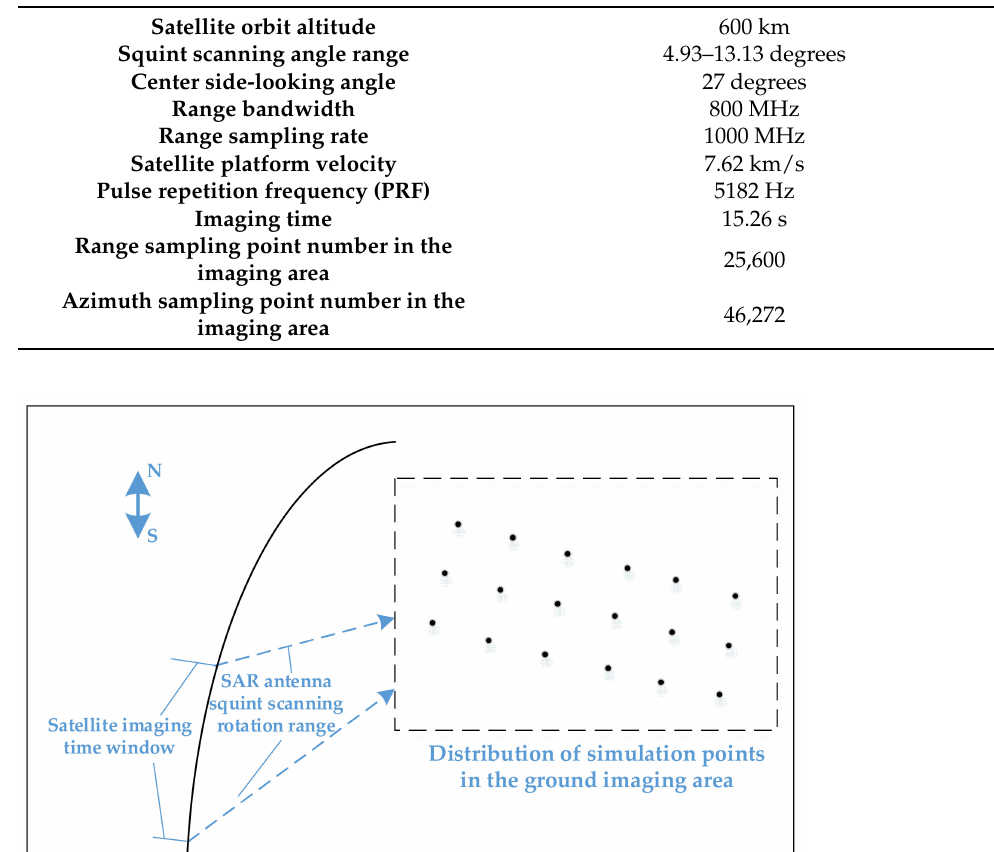
Table 1. Spaceborne SAR squint sliding-spot imaging simulation parameters.